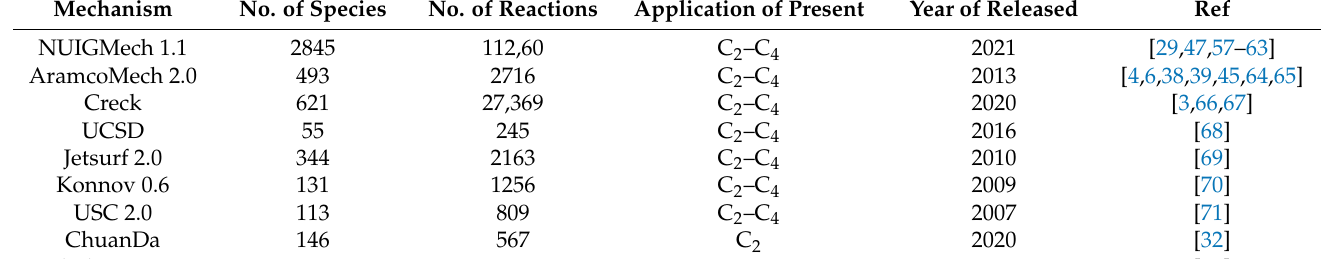
Table 3. Summary of mechanism selected in this study.